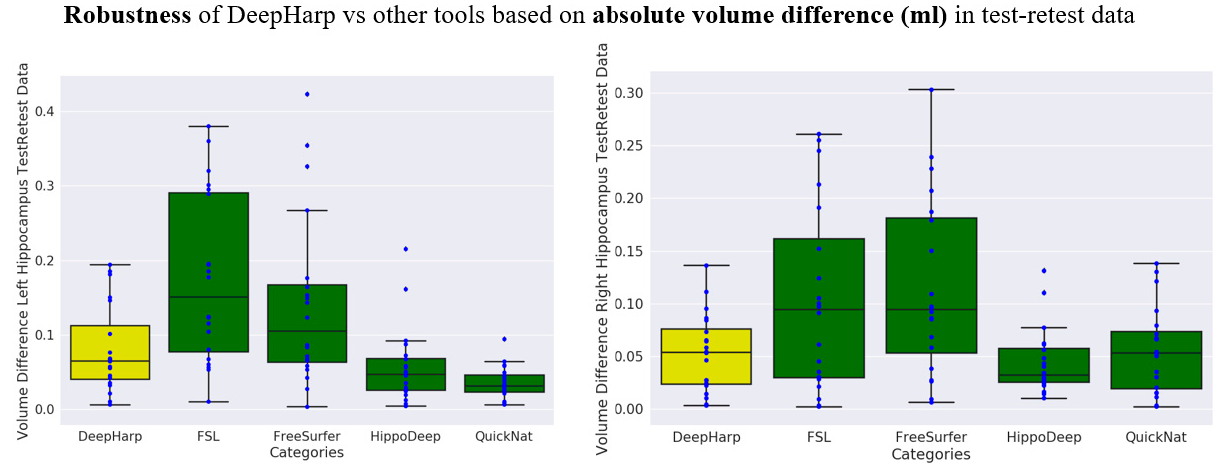
Figure 8. Comparison of DeepHarp robustness (based on absolute volume difference) with common tools and state ‐ of ‐ the ‐ art methods for hippocampus segmentation.